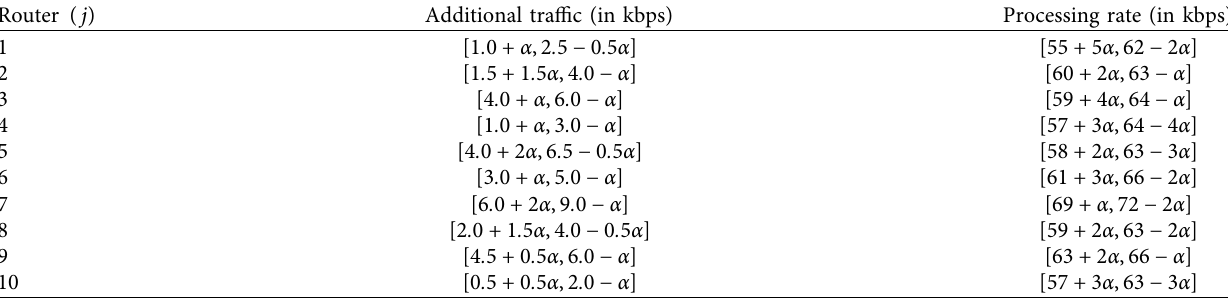
) and processing rate ( 􏽥 C j